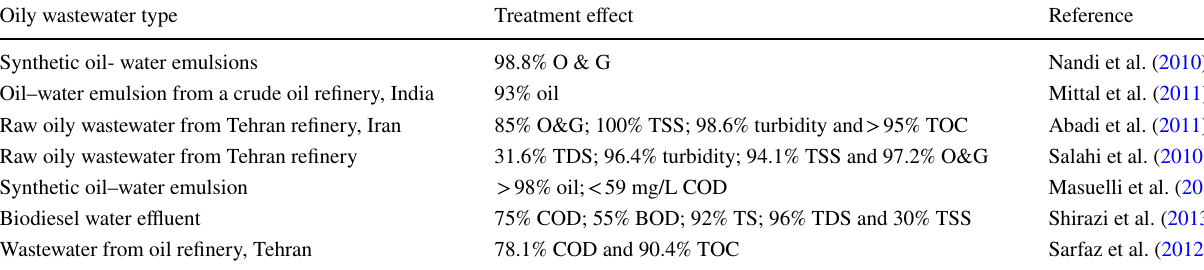
Table 3 Efficiencies of membrane technology in the removal of pollutants from oily wastewater Oily wastewater